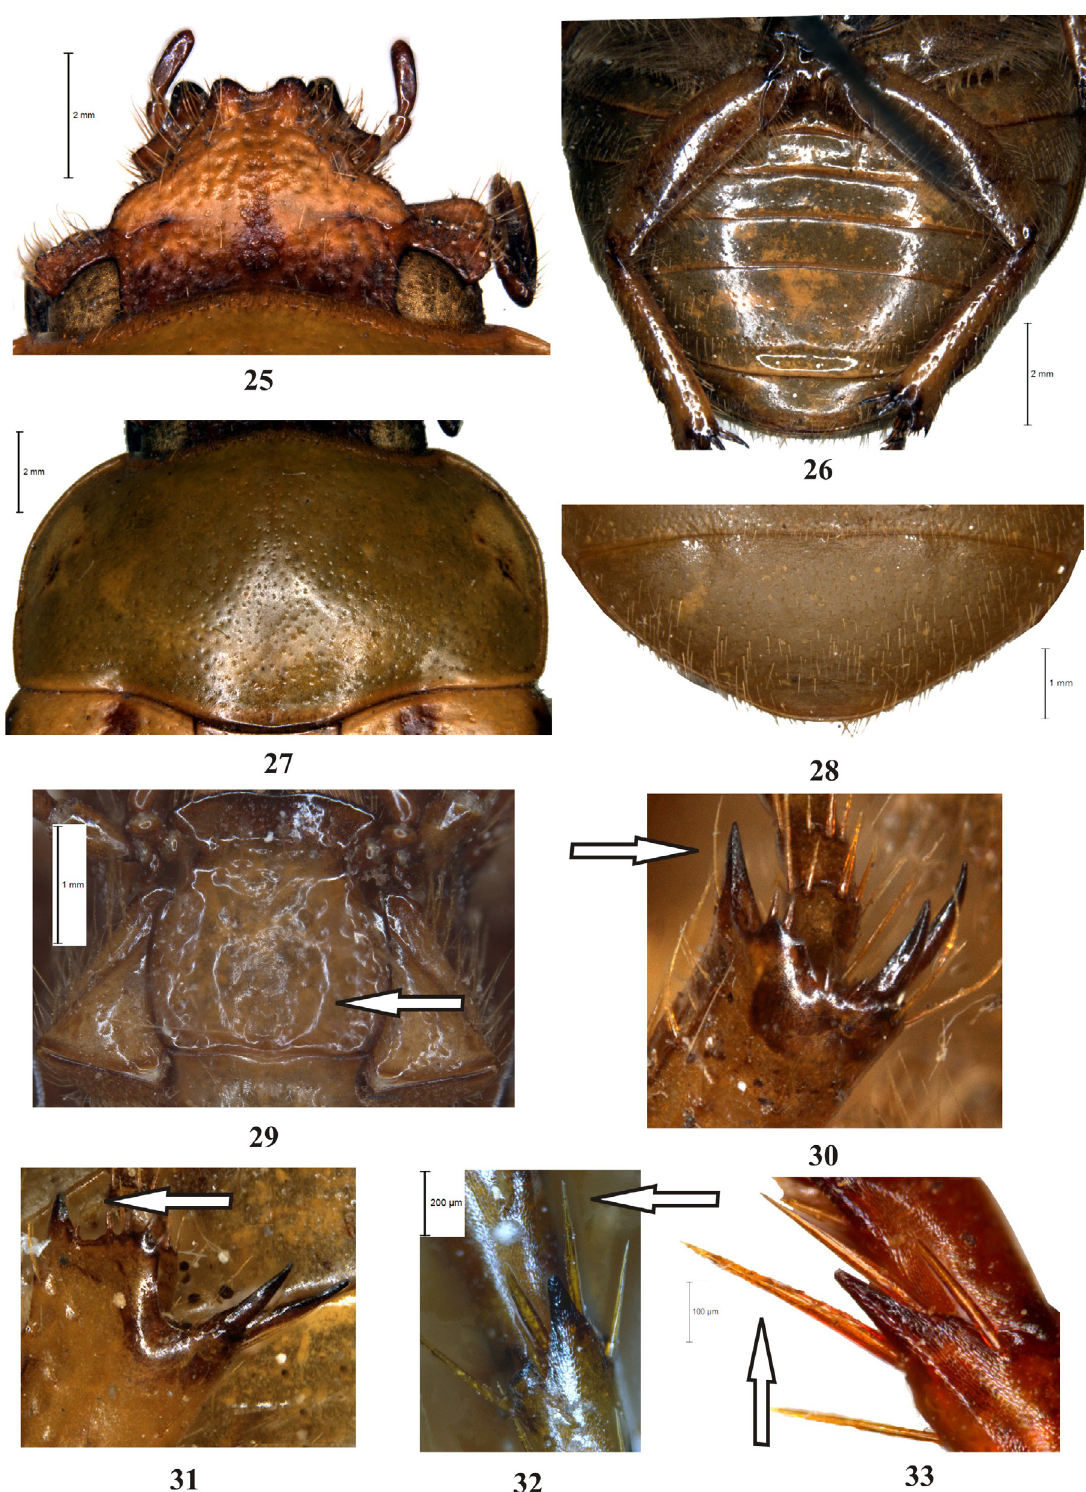
Figs 25–33. Pukupuku arunachalensis sp. nov., paratype, ♀. 25 . Clypeus. 26 . Abdomen. 27 . Pronotum. 28 . Pygidium. 29 . Mentum. 30 . Apical part of mesotibia. 31 . Apical part of metatibia. 32 . 4 th mesotarsomere. 33 . 4 th metatarsomere. (Arrows indicate the character separating Pukupuku from the closely related